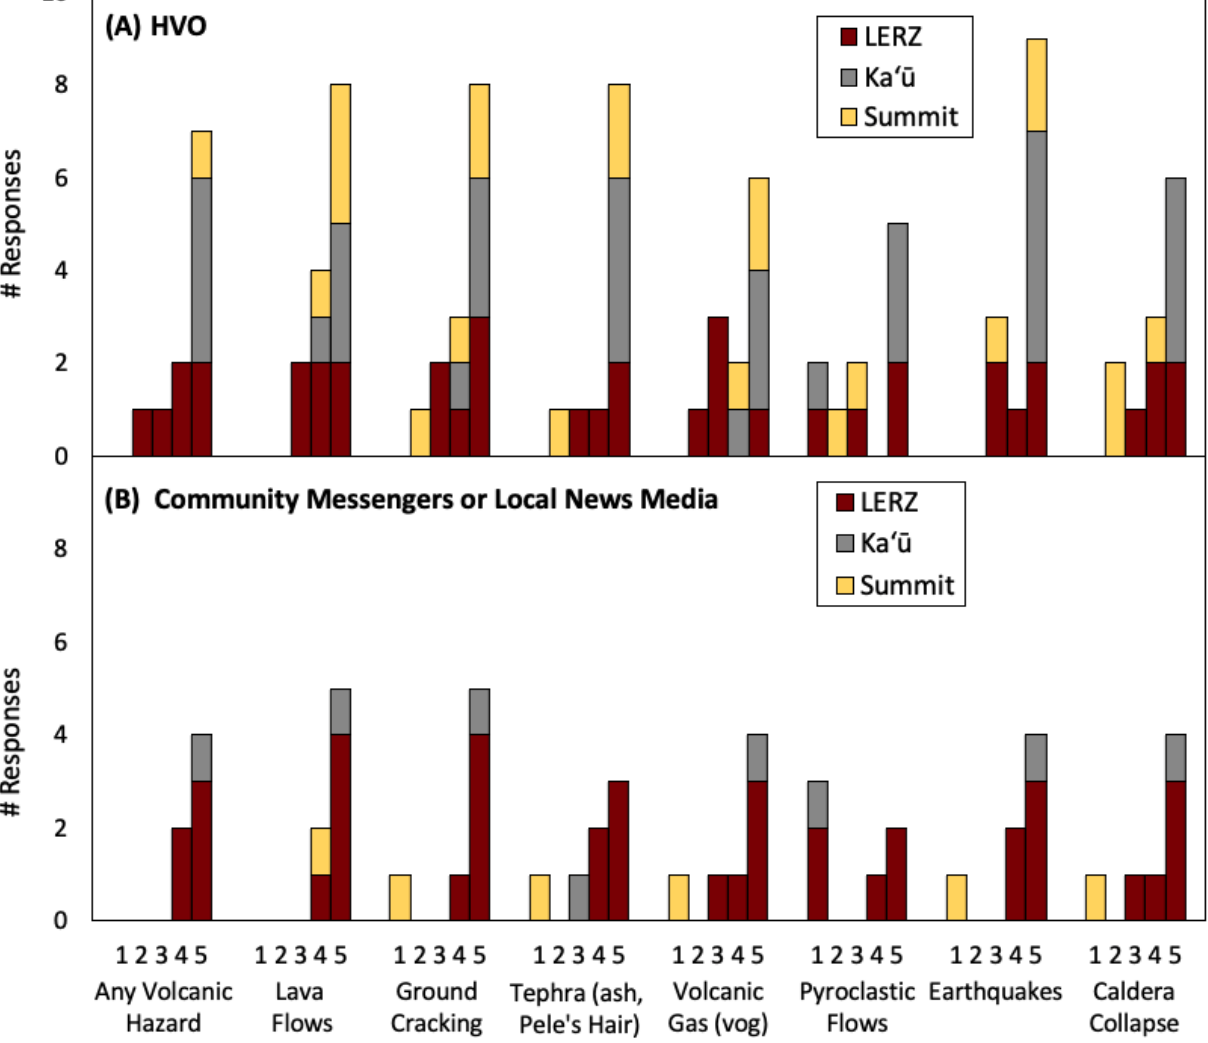
Figure 7: Participants’ responses regarding the communication of specific hazards from [A] U.S. Geological Survey Hawaiian Volcano Observatory (HVO) and [B] community messengers (LERZ participants only) or local news media (Ka ‘ ¯u and summit participants). For each source/messenger, Likert-type scores address the following question: “How helpful do you think infor- mation about the eruption was with respect to ...” each of the hazards labeled at the bottom of the plot. Our Likert-type scale corresponds with the following qualitative descriptions: 1: “not at all (helpful)," 2: “not much (help),” 3: “fair(ly) (helpful),” 4: “great (help),” 5: "very great